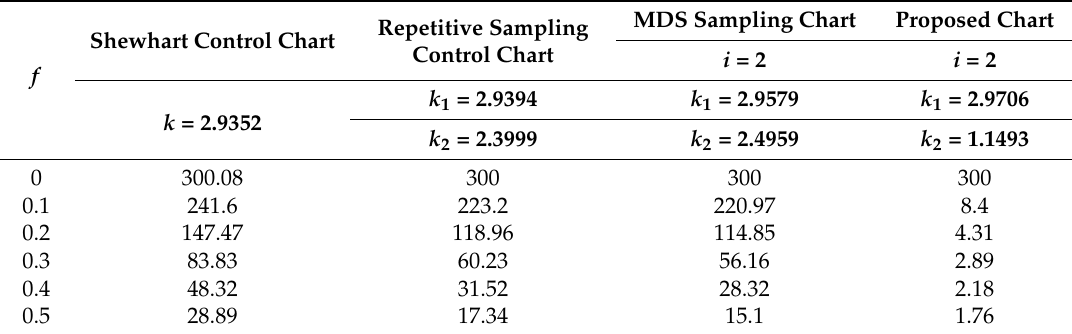
Table 9. ARL comparison when ARL = 300, n = 5, rho =